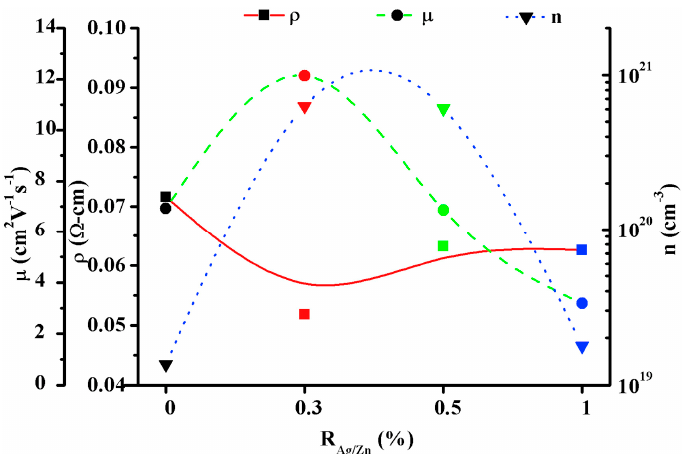
Figure 12. Variation in resistivity, charge carrier density, and mobility of the ZnO:Al:Ag nanostruc- tures with Ag doping. Reproduced with permission from ref. [75]. Table 2. Solution processed co-doped ZnO in different morphologies, along with their functional properties. Here, AIZO = Al, In co-doped ZnO; AGZO = Al, Ga co-doped ZnO; TAZO = Sn, Al co- doped ZnO; ODL = optimal doping level (at%) of aluminum; T = transmittance (%) of AZO in the visible region; E g = band gap (eV) of AZO; and ρ = resistivity ( Ω cm) of AZO.